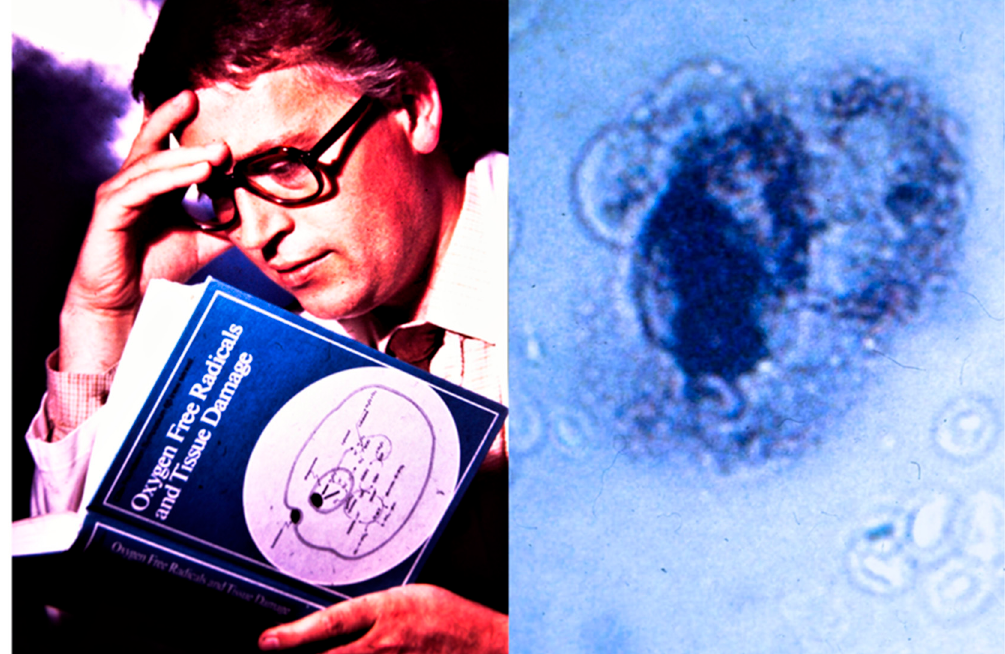
Figure 5. Gerriet Loschen reading the proceedings of the Ciba Symposium on “Oxygen Free Radicals and Tissue Damage” [239]. The cover illustration schematically represents a phagocytosing white blood cell, as shown in [240]. The picture was taken in 1980 by L. F. The right panel shows a more realistic version of phagocytosis: a white blood cell swallowing opsonized yeast (phase contrast microscopy). •O 2 − is stained with tetrazolium blue. Notice that most of the dye is precipitated in the phagocytic vacuole, but also faintly spread over the entire surface of the cell. The right picture was taken by G. L. in 1980.